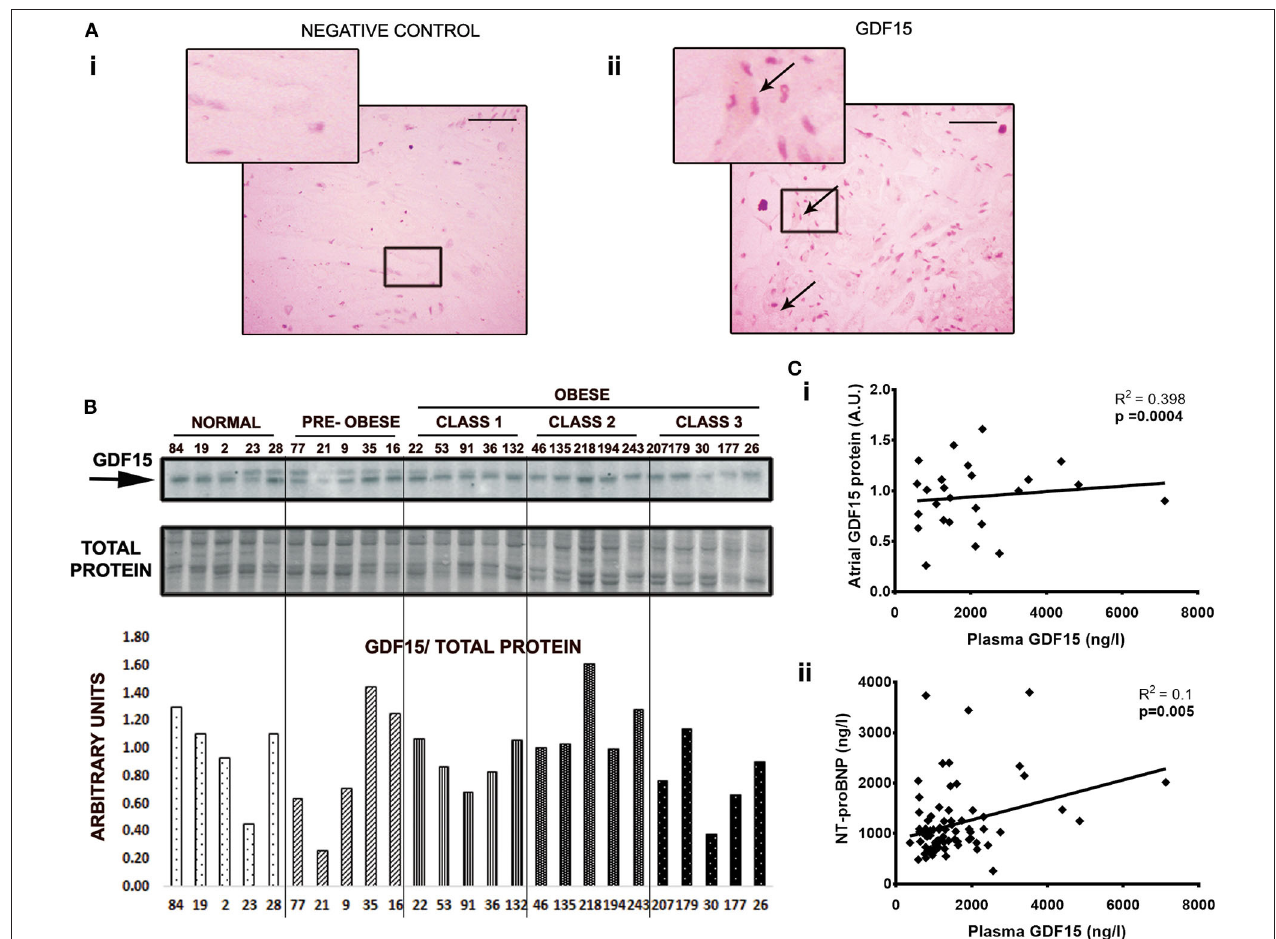
FIGURE 2 | GDF15 protein expression in atrial tissues (AA) correspond with circulating GDF15. (A) Low to moderate cytoplasmic expression of GDF15 was observed in atrial tissues. (i) , Negative control. (ii) , GDF15 immunohistochemistry. (B) GDF15 showed weak protein expression in atrial tissue. GDF15 protein was normalized to whole protein stain. (C) Plasma GDF15 correlates with protein expression (i) , and with NT-proBNP, a marker for heart failure (ii) . Data were analyzed using Pearson’s correlation and linear regression. For immunochemistry, outer magnification: 40X, scale bar: 50 µ m. Arrows represent protein